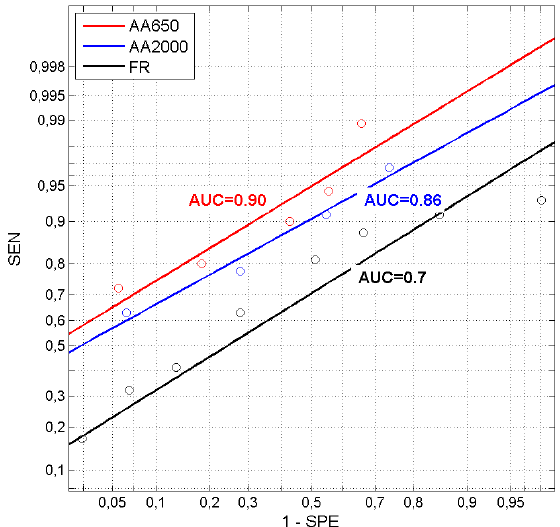
Figure 11. Receiver operating characteristics for tests based on average absorbance for AA650 and AA2000 and resonance frequency (FR) plotted in units of inverse normal distribution ( z -scores). Points in the graph are actual experimental values and the lines show a linear approximation of ROC curves. AUC values for each curve are also shown.